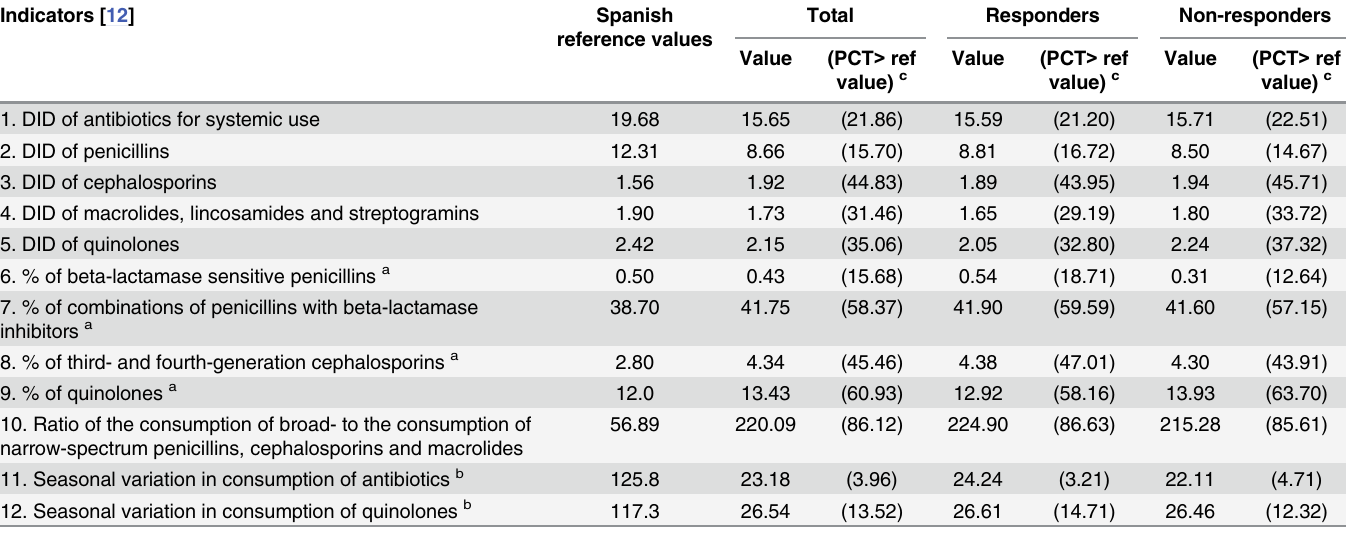
Abbreviations. PCT: percentage DID: doses inhabitant day a Percentage of total consumption of antibacterials for systemic use (J01) in DID.